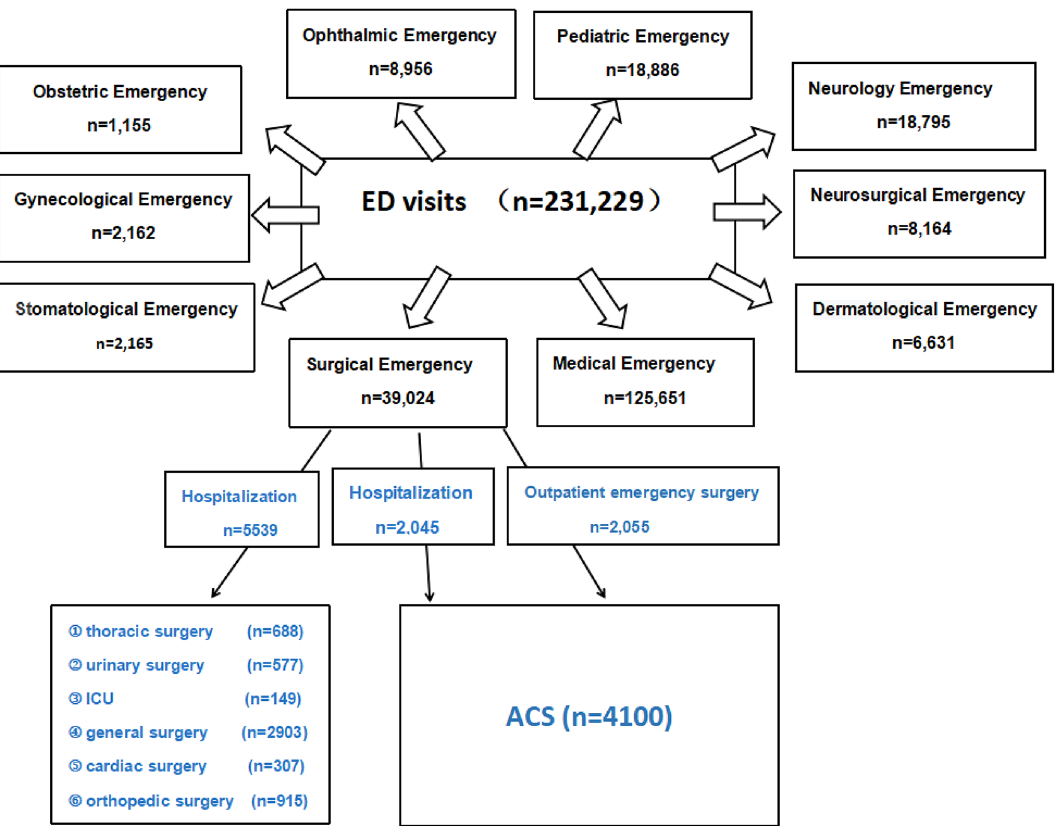
Figure 2. The population and distributing of ED visits at the First Affiliated Hospital of Harbin Medical University between 1 January 2018 and 1 January